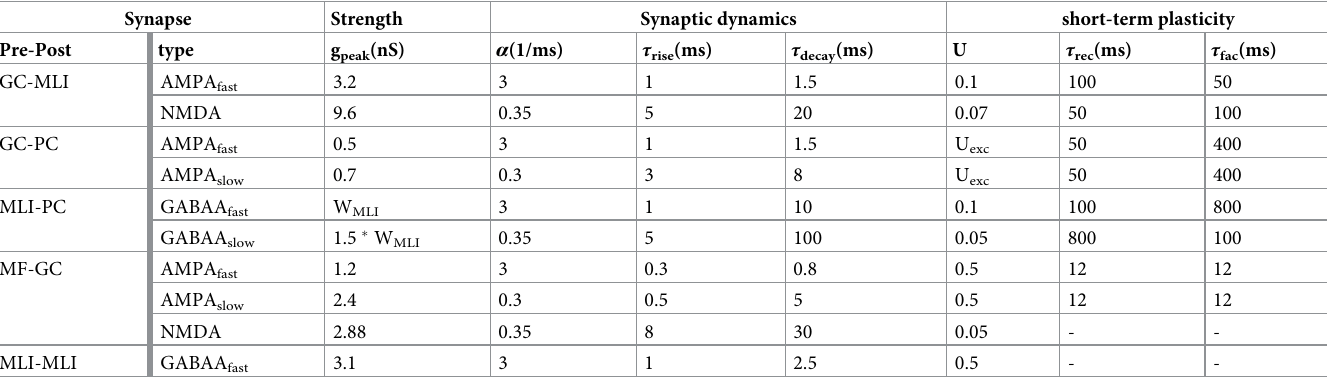
Table 2. Synaptic parameters for each synapse in the model. Synapse Strength Synaptic